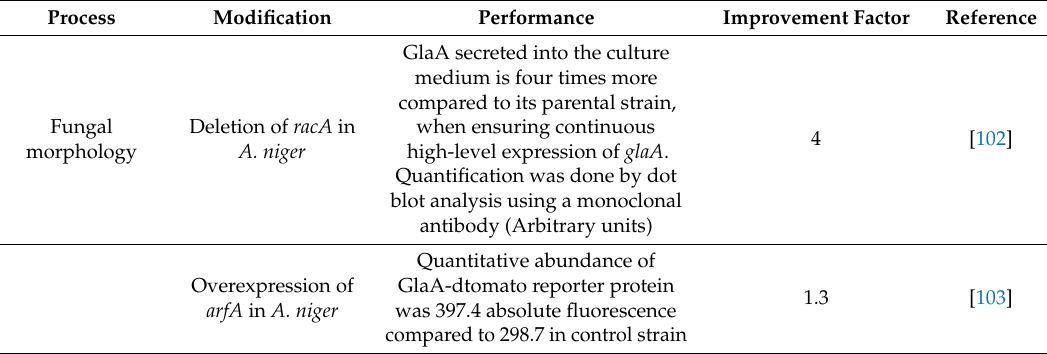
Table 11. Approaches for improving recombinant protein production through engineering genes involved in fungal